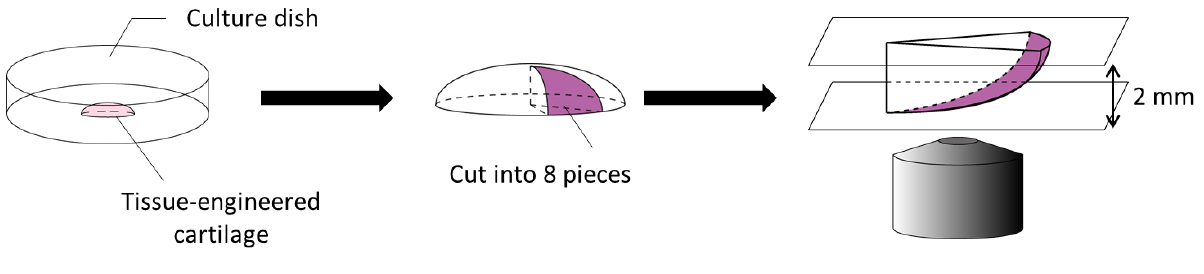
Fig. 2 Harvesting and placement of samples for